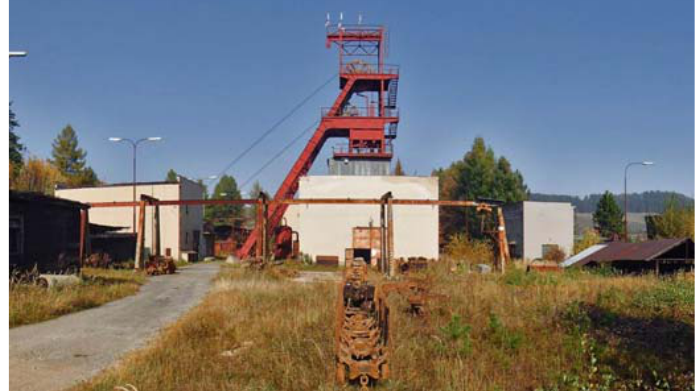
Figure 5. Panorama of the solved site (photo Záveská, K.).